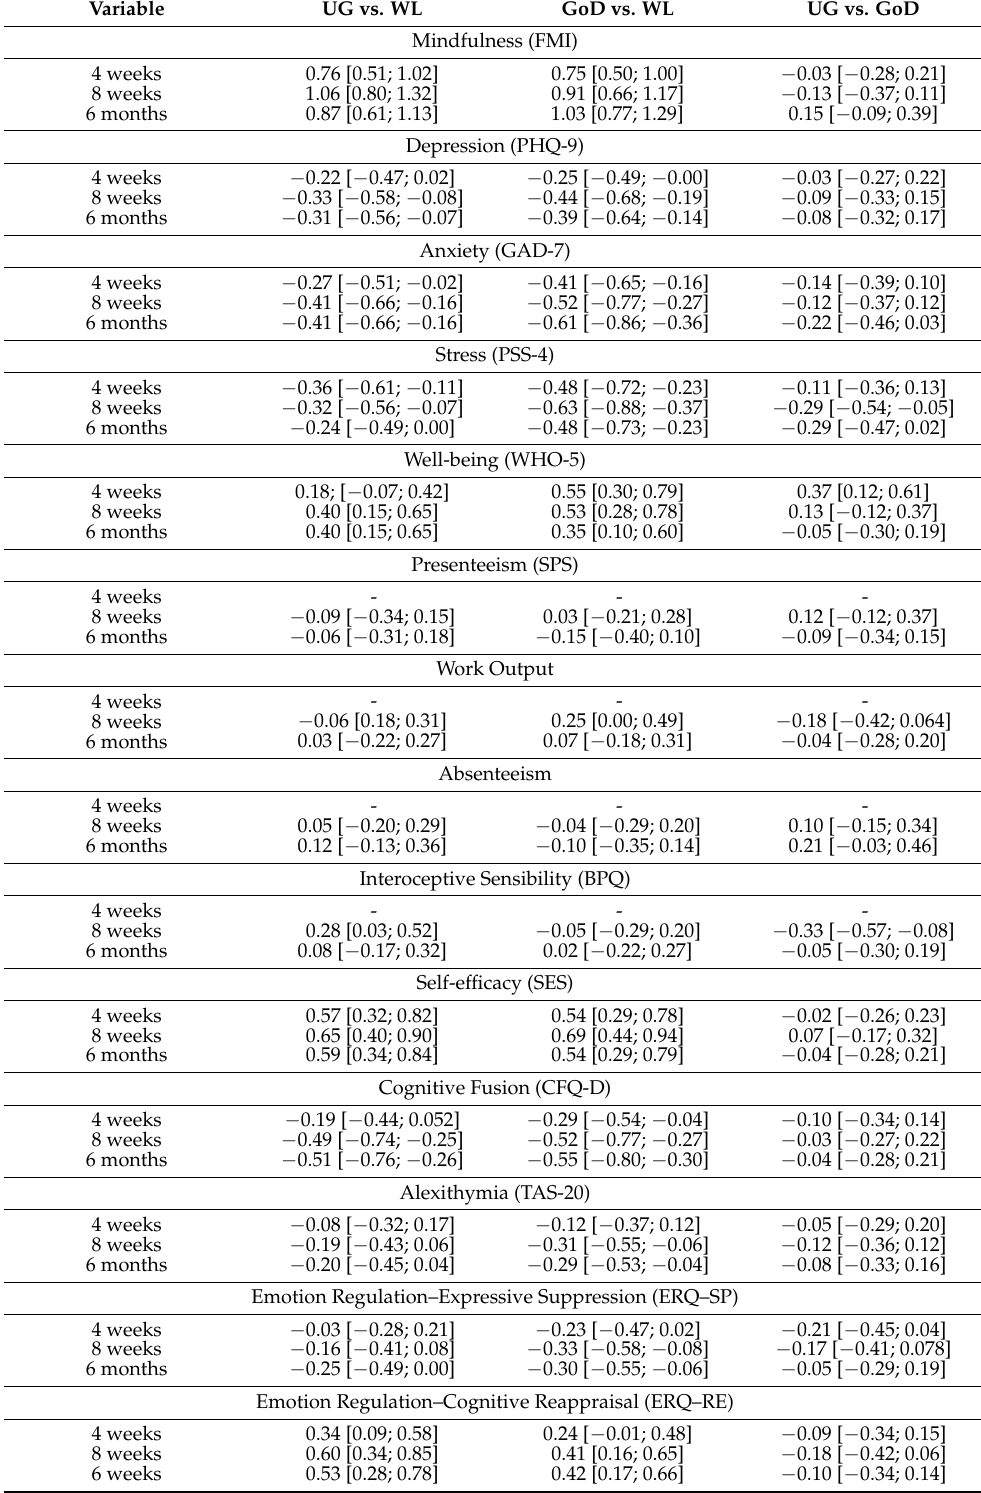
Table 4. Effect sizes (Cohen’s d , 95% CI),